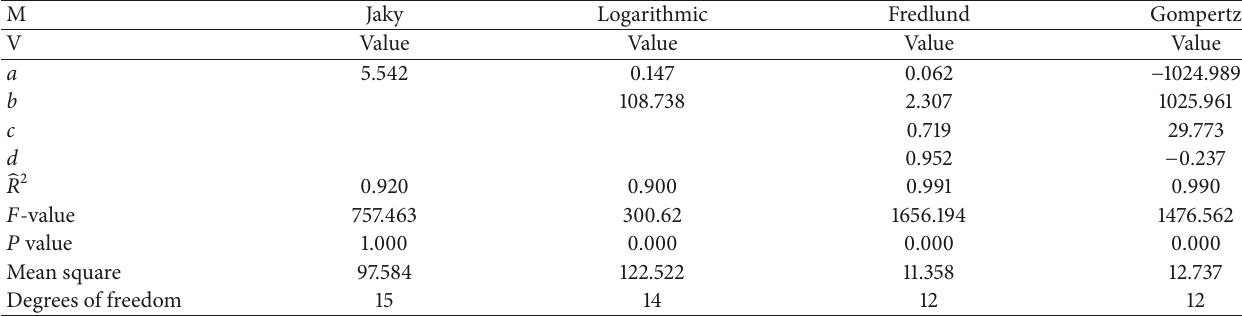
Table 6: Fitting parameters of H-5 by sieve-pipette method.